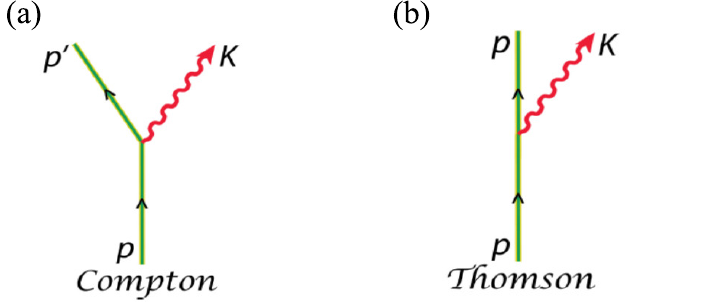
Figure 6. Vertex of the Feynman diagram expressing the difference between Compton ( a ) and Thomson Scattering ( b ). In case ( b ), the electron dynamics remain practically unperturbed after the interaction